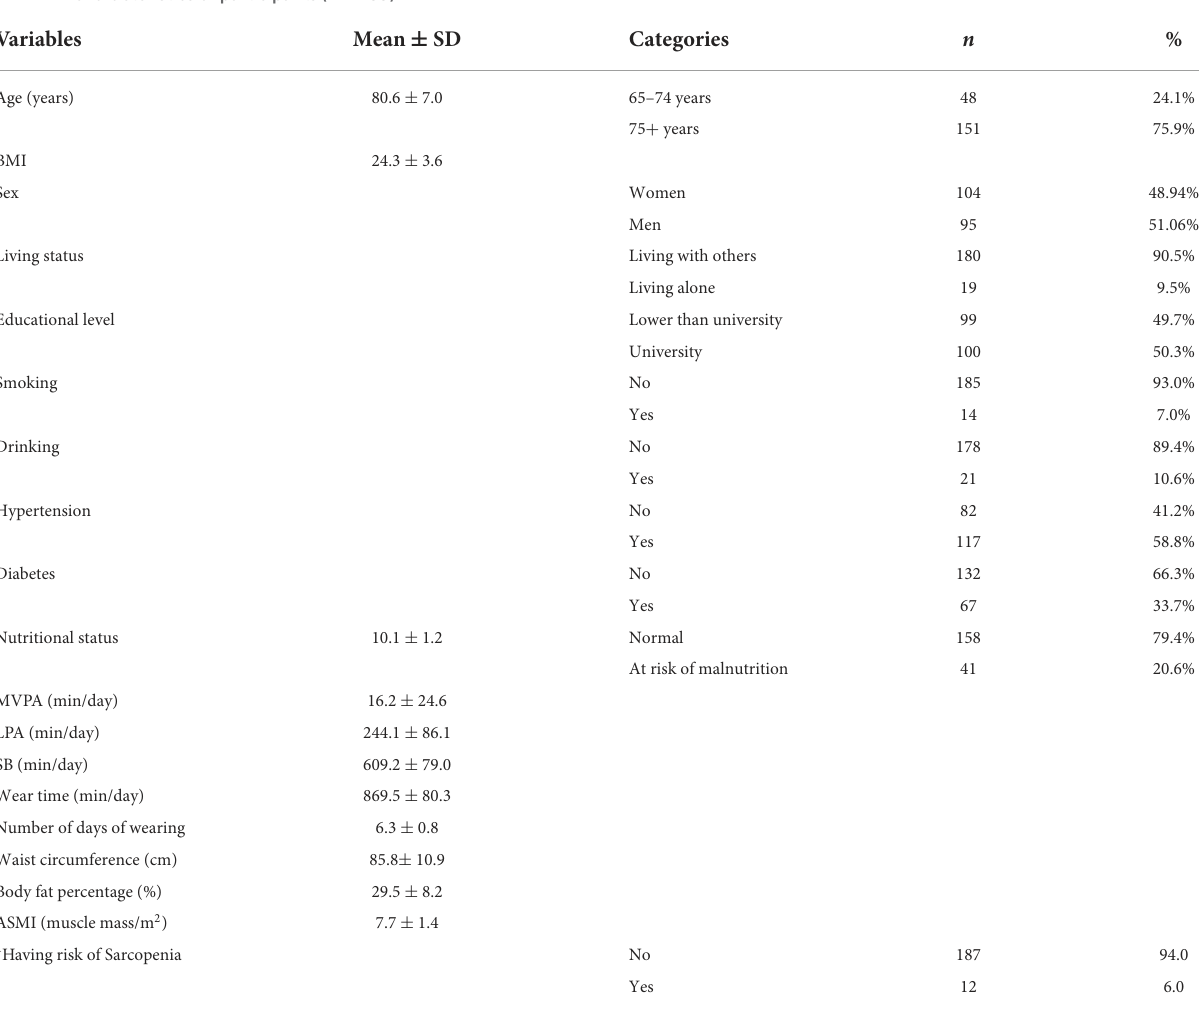
TABLE 1 Characteristics of participants ( n =